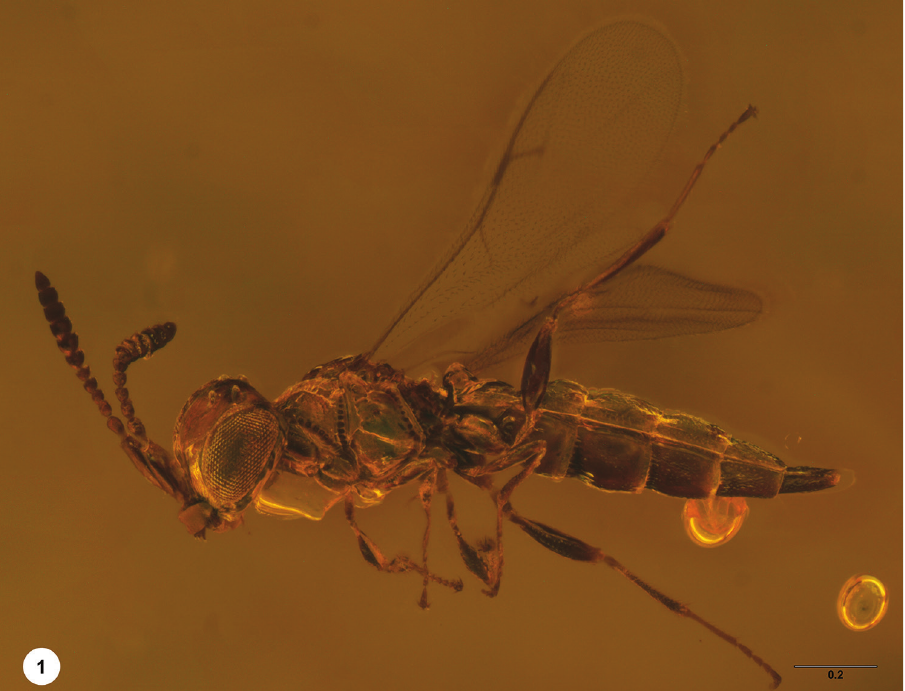
Figure 1. Archaeoteleia astropulvis , female holotype (USNMENT01109982), habitus, ventrolateral view. Scale bars in